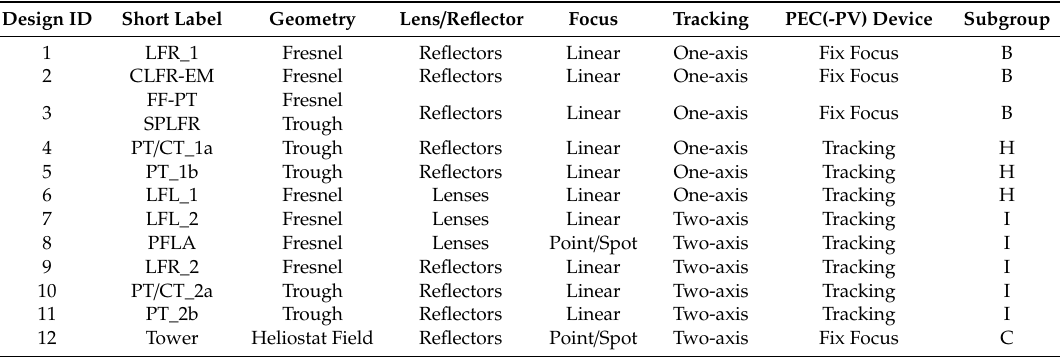
Table 4. Shortlist of design concepts for their